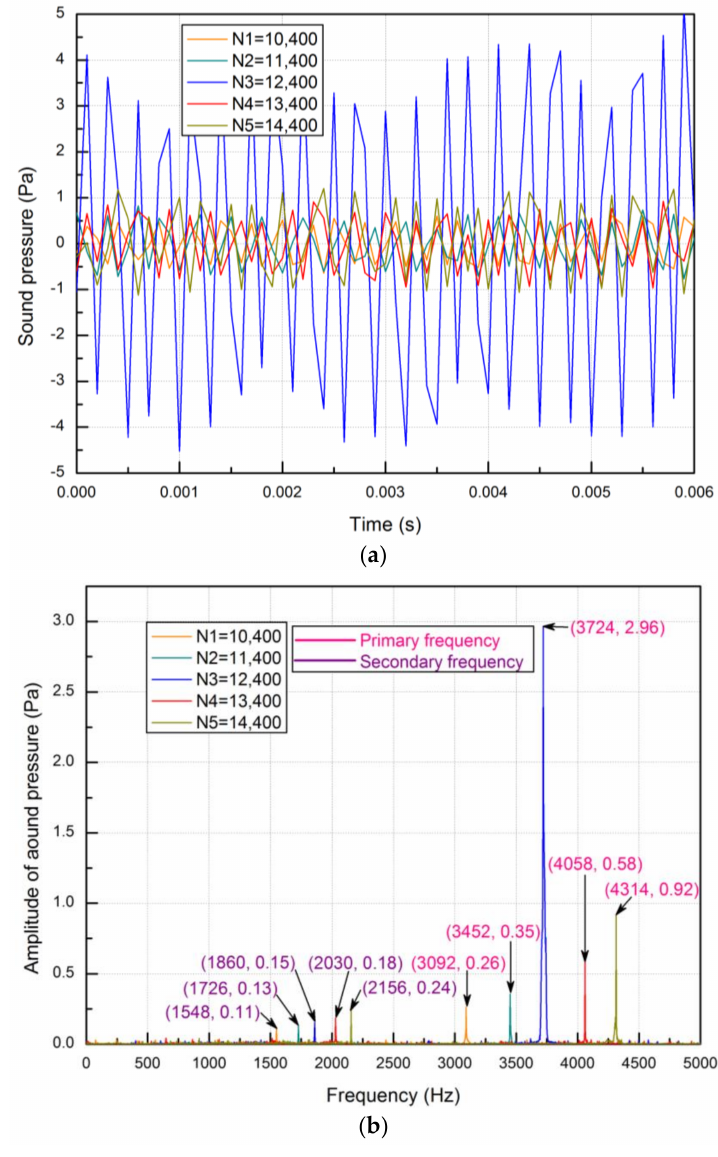
Figure 11. Noise characteristics for the Type A flapper-armature assembly: ( a ) in the time domain; ( b ) in the frequency